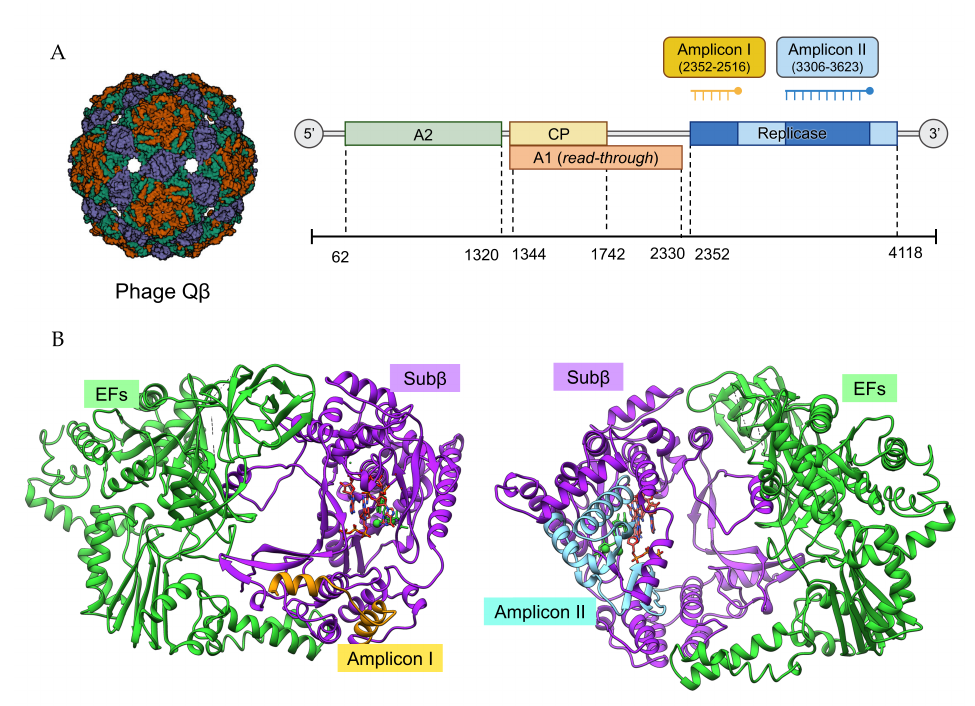
Figure 1. Organization of the Q β genome and the 3D structure of the virus–cell replicative complex. ( A ) Crystal structure of the capsid of the Q β phage [44] (left, 1QBE entry in the PDB) and its genome (right). Q β is an RNA virus with a genome of positive polarity and a capsid composed of about 180 copies of CP protein and a small number of Prot A1 copies, which self-assemble into a 28-nm- diameter icosahedral particle. The genome of Q β has a length of 4217 nucleotides and contains three open reading frames that encode four proteins: the maturation/lysis protein A2; the coat protein CP; a readthrough of a leaky stop codon in the coat protein, called A1; the β –subunit of an RNA-dependent RNA-polymerase (RdRp), termed the replicase. The two regions overlapping with the proteins that were sequenced (amplicons I and II) are indicated in the picture. ( B ) Two views of the 3D structure of the replicase protein (Sub β unit, in purple) in interaction with the cellular elongation factors (EF, green); see the Materials and Methods for 3D reconstruction methods. We highlight the regions of the replicase corresponding to the folded structure of amplicons I (orange) and II